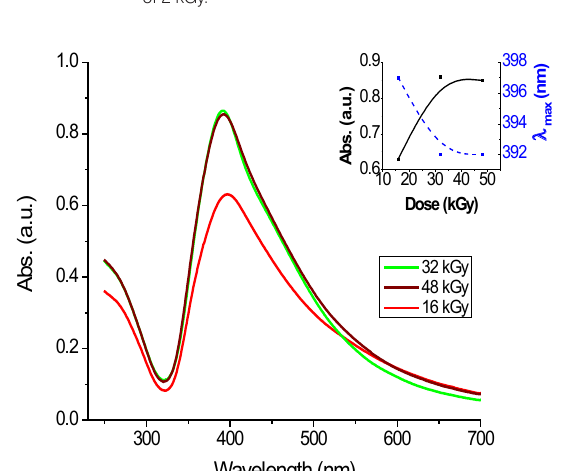
Figure 10. UV-VIS spectra for AgNPs samples obtained at high dose rate, composition type IPA. Inset: the effect of radiation dose on the absorption peak